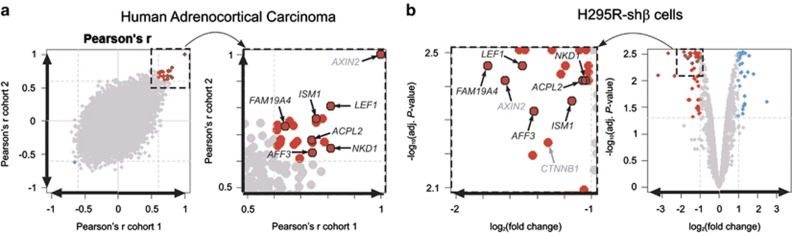
Identification of Wnt/βcatenin target genes in adrenocortical cancer. (a) To identify gene's expression that is closely correlated with AXIN2 expression and that might also be Wnt/β-catenin targets, we performed Pearson's r correlation tests with expression data sets from two independent cohorts of ACC (cohort 18 and cohort 210). Each dot in left panels represents the Pearson correlation coefficient (r) for each gene in the two cohorts (detailed in figure S01-A and Supplementary Table S1). The genes best correlated with AXIN2 are represented in red (positively; r>0.6 in both cohorts) or blue (negatively; r<–0.6 in both cohorts). (b) The volcano plot in the right panels shows the differential expression of genes in three stable clones of the human adrenocortical cell line H295R, which carries a construct encoding a doxycyclin-inducible shRNA targeting CTNNB1 mRNA (shβ). Dots in gray represent genes that did not show significant changes in expression, dots in red on the left indicate the genes with significantly downregulated expression (adjust P-value<0.05 and log2 ratio<–1) and dots in blue on the right indicate the genes with significantly upregulated expression (adjust P-value<0.05 and log2 ratio>1). Black circles represent the genes common to both analyses.